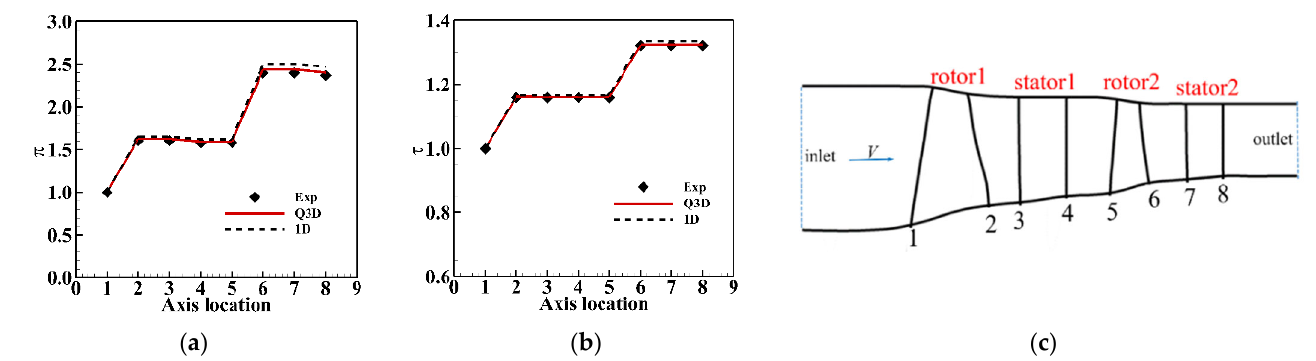
Figure 2. Comparison of performance parameters. ( a ) Total pressure ratio; ( b ) Total temperature ratio; ( c ) The distribution of axis location.